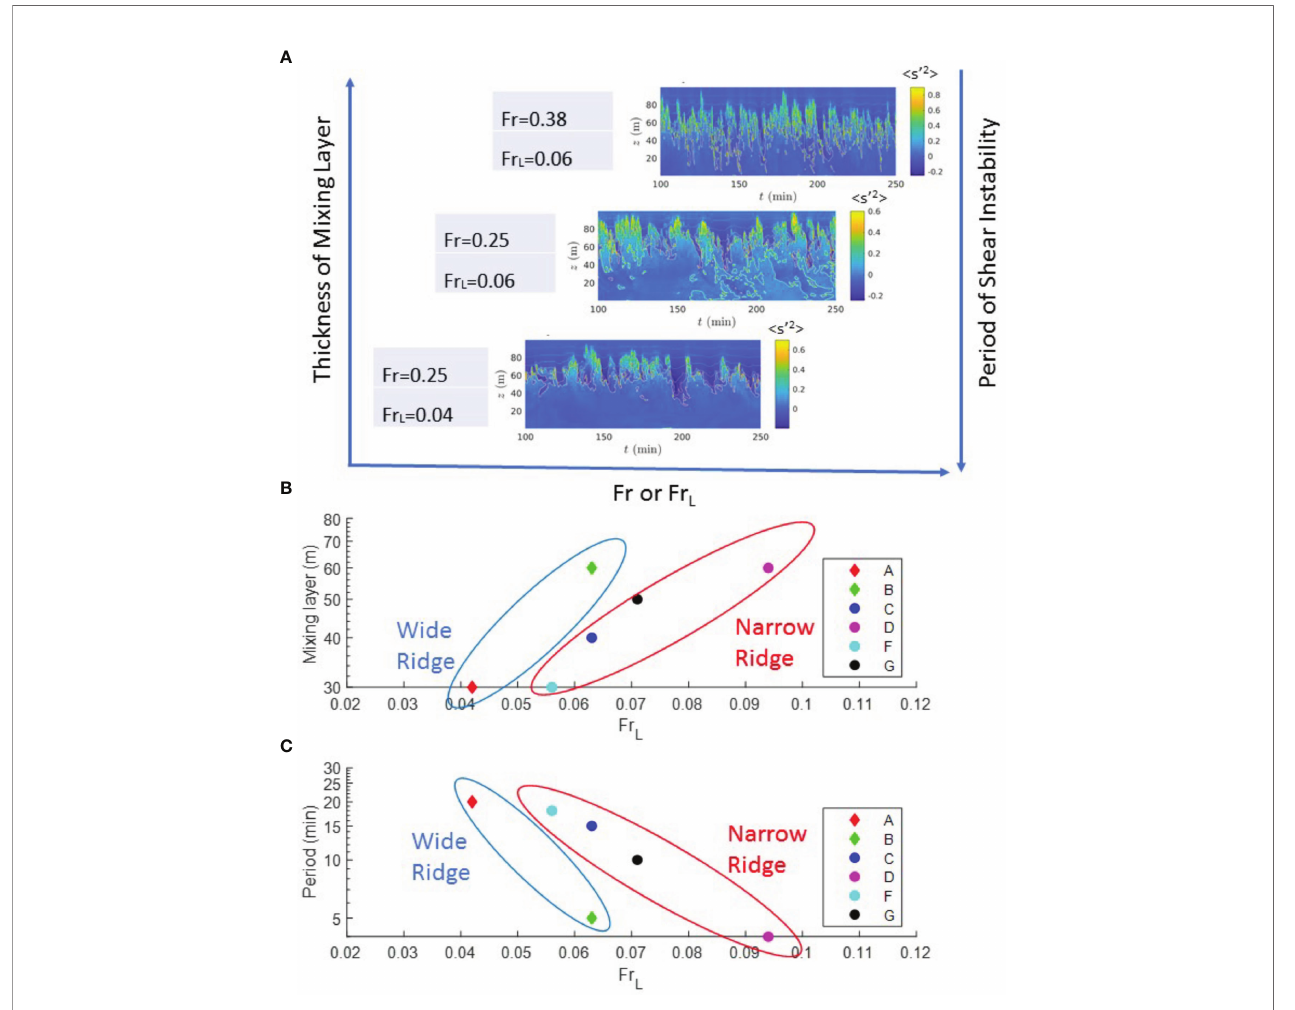
FIGURE 12 | (A) A diagram including the density variance of Case A-C shows the period of shear instabilities and the thickness of the mixing layer are relevant to Fr or Fr L . Diagrams show the relationship of Fr L versus (B) the thickness of the mixing layer (unit:meter) and (C) the period of shear instabilities (unit: